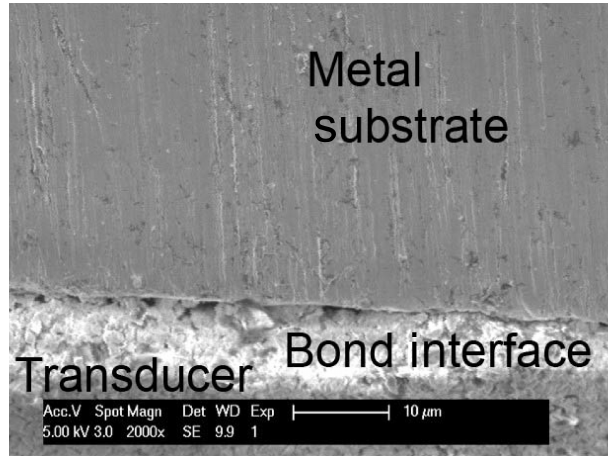
Figure 2. The interface between the ceramic and metal for the induction-sintered